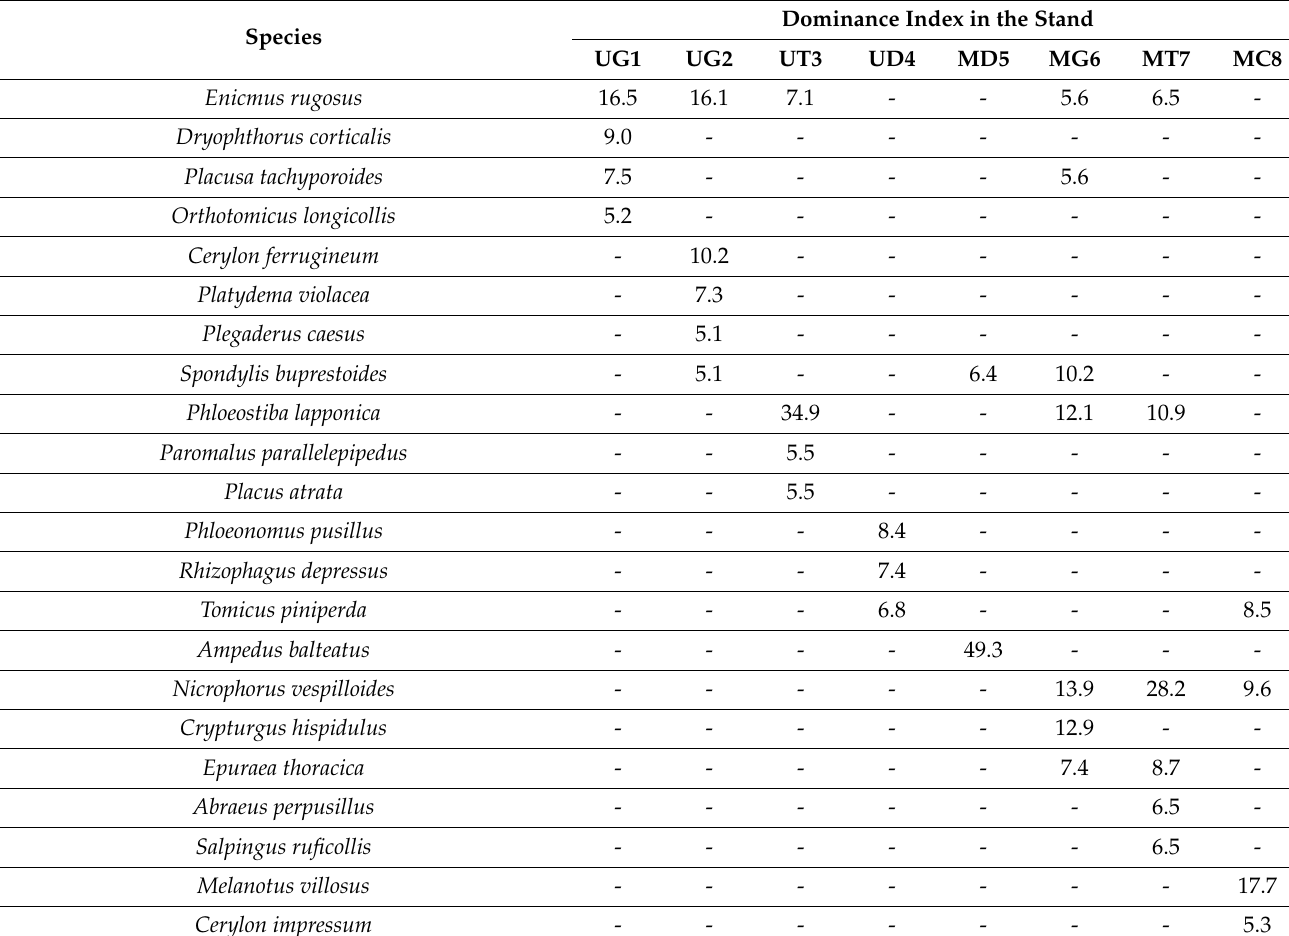
Table 3. Dominant beetle species (D > 5%) captured in individual stands.